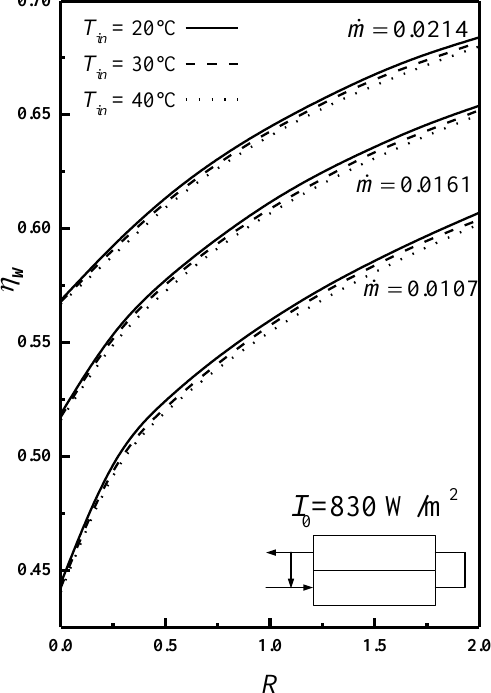
Figure 5. Effect of the inlet air temperature on collector efficiency in wire mesh packed solar air heaters with recycle ( I 0 = 830 W/m 2